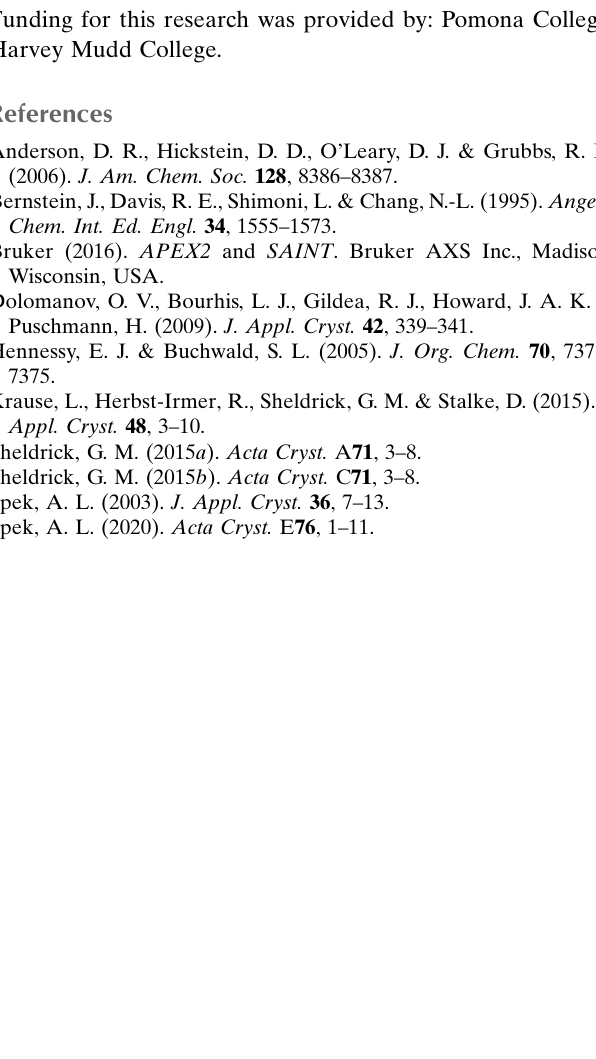
Table 2) having the R 2 1995).